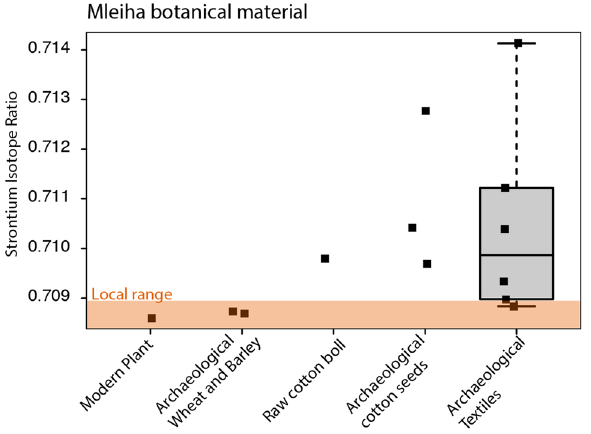
Figure 2. Strontium isotope variation of the botanical remains found at Mleiha. Local range (marked by orange band) is defined by modern vegetation (n = 25) from southeastern Arabia 32